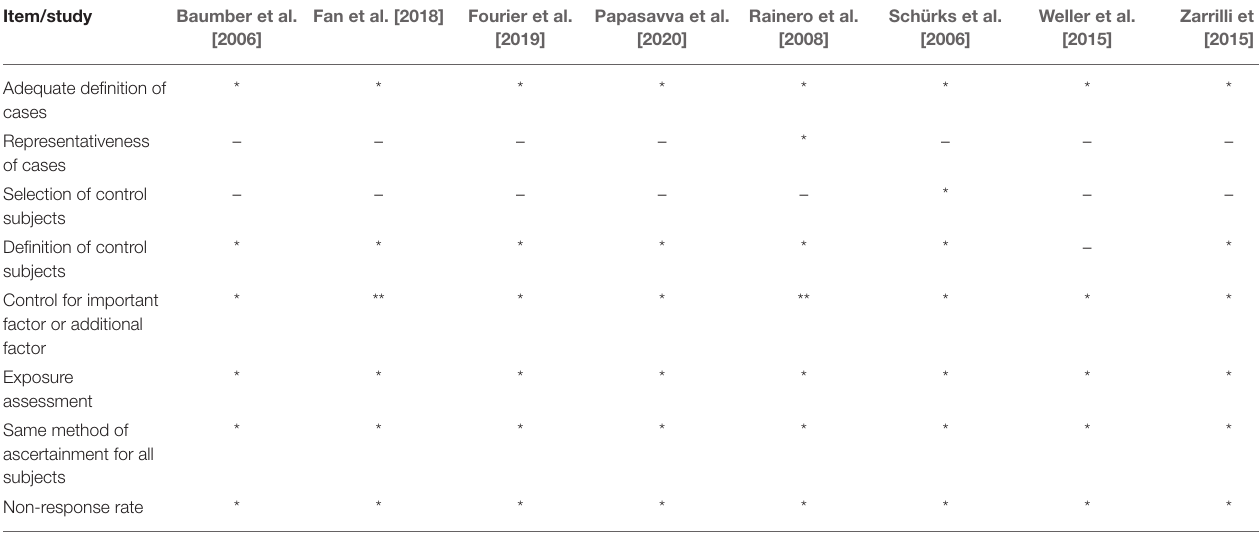
TABLE 2 | Quality assessment of included studies based on of the Newcastle-Ottawa